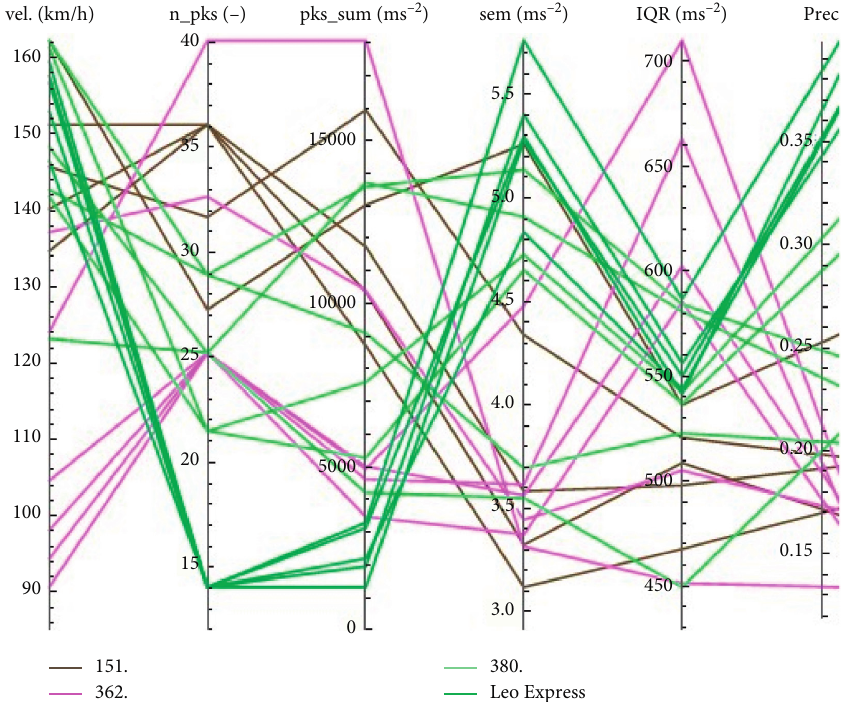
Figure 9: Visualization of clustering of scalar features for individual train passages sorted by train